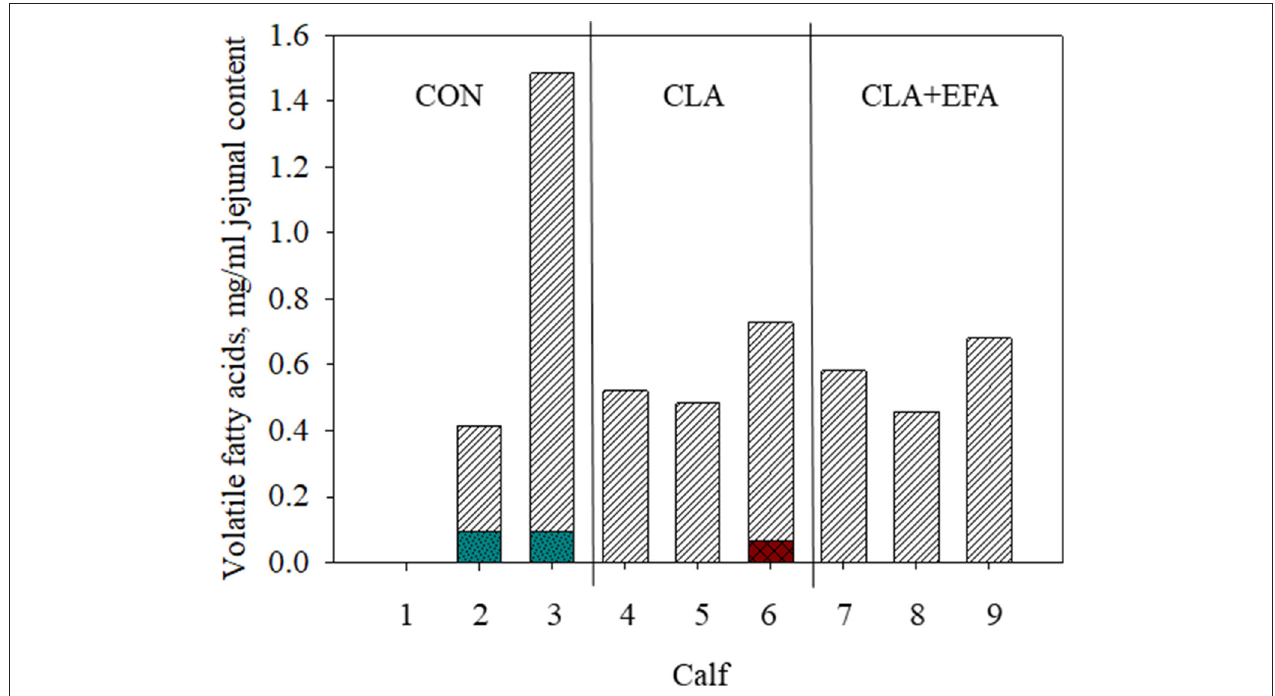
FIGURE 1 | Volatile fatty acid content (striped white bars, acetic acid; checkered red bars, iso-butyric acid; pointed turquoise bars, butyric acid) in jejunal content depending on maternal fatty acid supply (CON, control group = coconut oil; CLA, conjugated linoleic acid = Lutalin ® ; CLA + EFA = Lutalin ® + linseed oil + safflower oil) in calves 1–9 (animal 1 have to be excluded from measurements because of insufficient intestinal